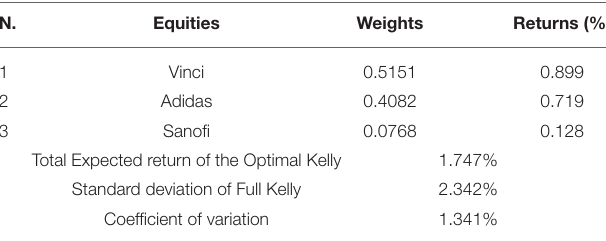
TABLE 5 | Risk-Return performance measurements for the compared strategies in the single equity case (daily data).